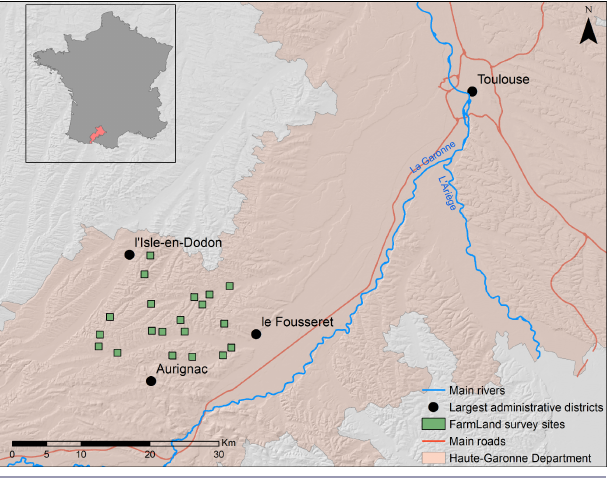
Fig. 1. Location of the study area. Inset: